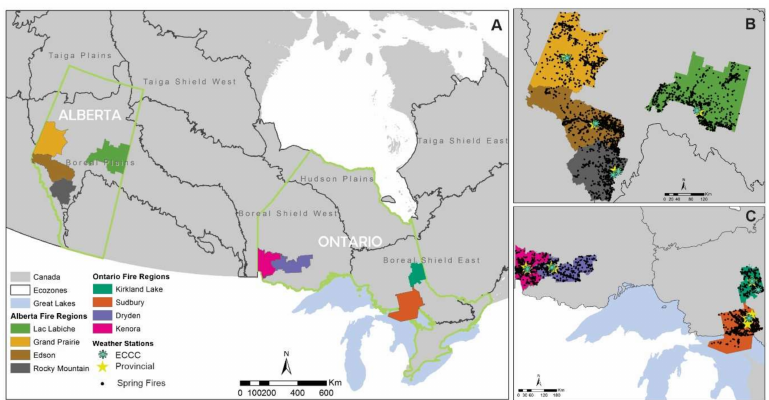
Figure 1. ( A ) Forest ecozone map for Canada showing the eight operational fire regions selected for the study. Four are located in the province of Alberta and four in Ontario. Close up of Alberta ( B ) and Ontario ( C ) regions showing all spring fires and location of weather stations used in the